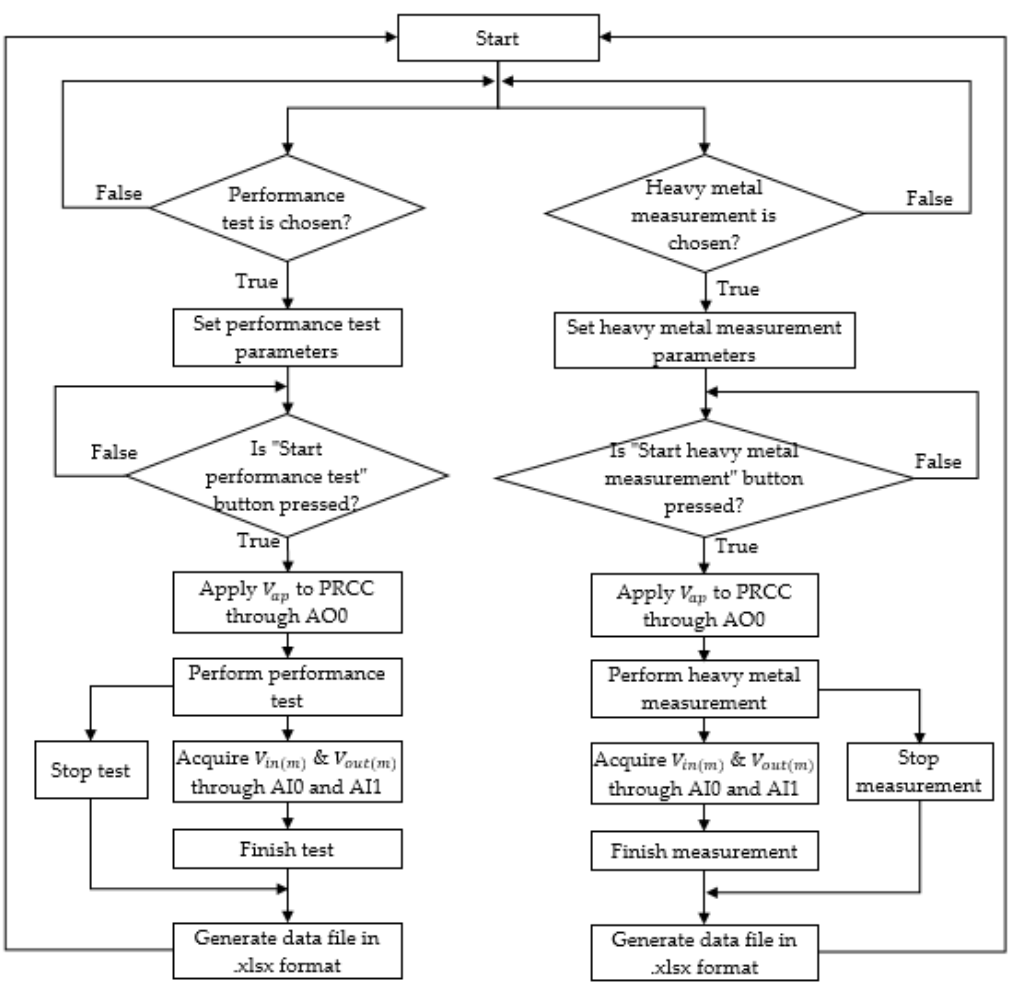
Figure 3. Flow chart of graphical program for signal generation (apply potential, V in ) and acquisition (measured input potential, V in ( m ) and measured output potential, V out ( m ) ).